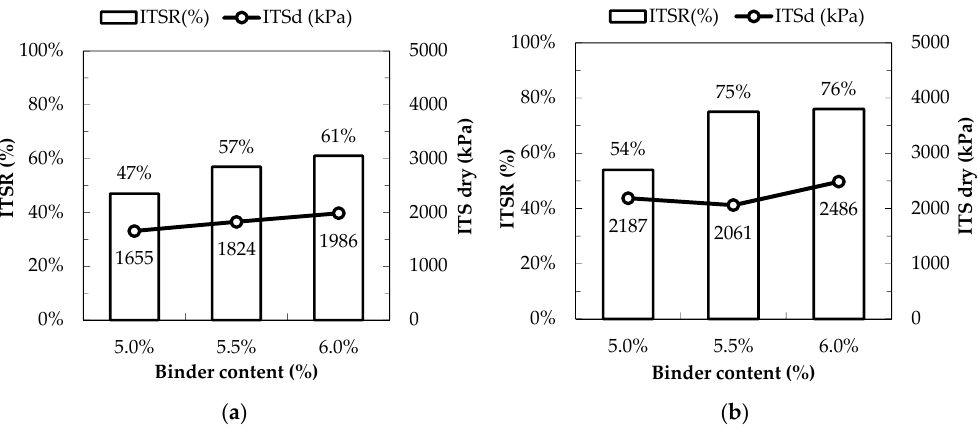
Figure 8. Influence of binder content in the water sensitivity test results for: ( a ) Asphalt mixture with PEX and 50/70 bitumen; ( b ) Asphalt mixture with PEX and PMB 45/80-60 binder.